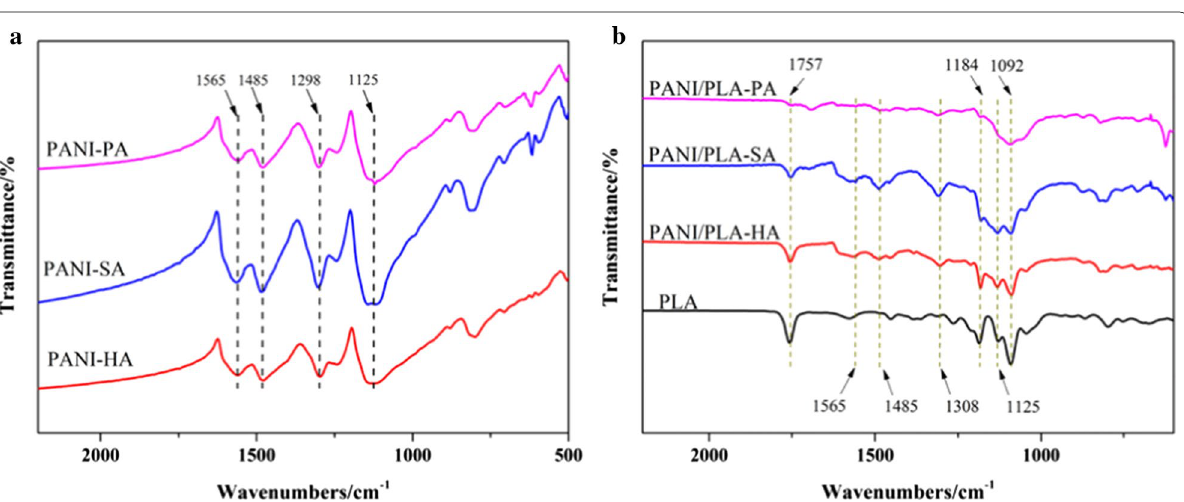
Fig. 6 FTIR spectra of a PANI, b PLA and PANI/PLA composite